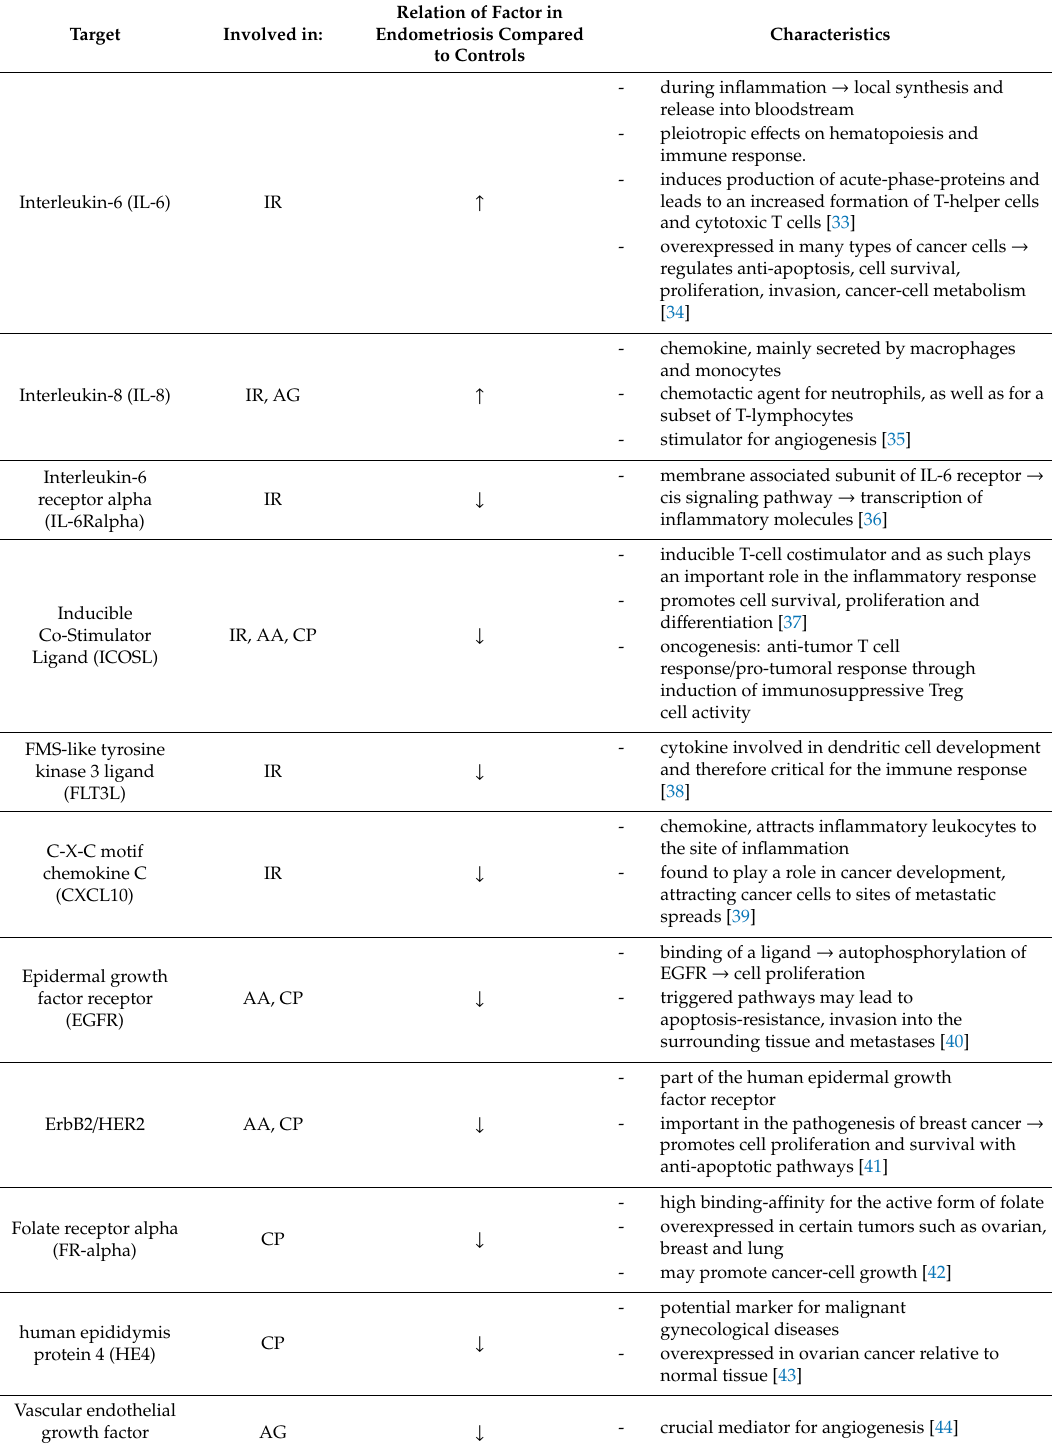
Table 4. Summary of the characteristics of factors that are significantly enriched or depleted in endometriosis patients compared to